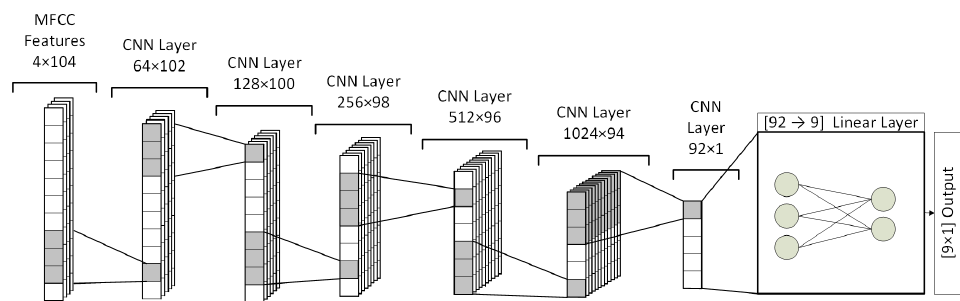
Figure 8. Structure of CNN-based fault classifier.